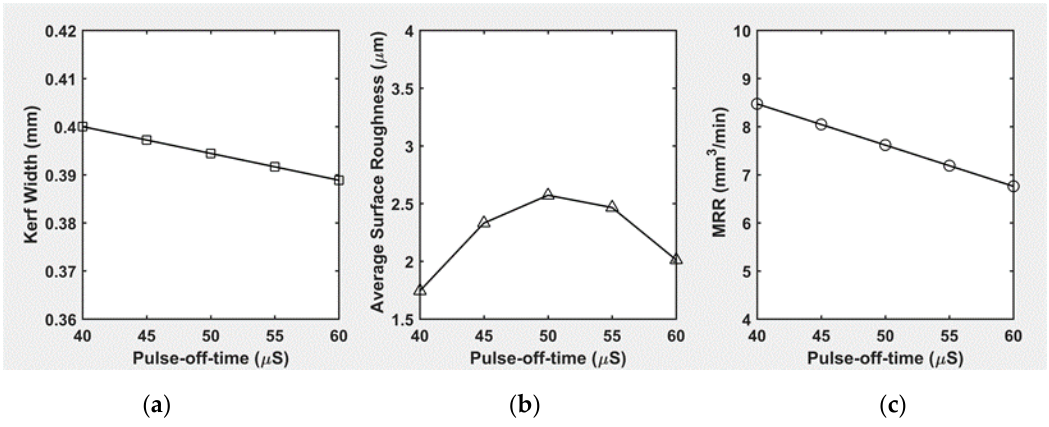
Figure 5. Effects of pulse-off-time (T OFF ) on ( a ) kerf width, ( b ) surface roughness and ( c ) MRR. Figure 5. E ff ects of pulse-o ff -time (T OFF ) on ( a ) kerf width, ( b ) surface roughness and ( c ) MRR.